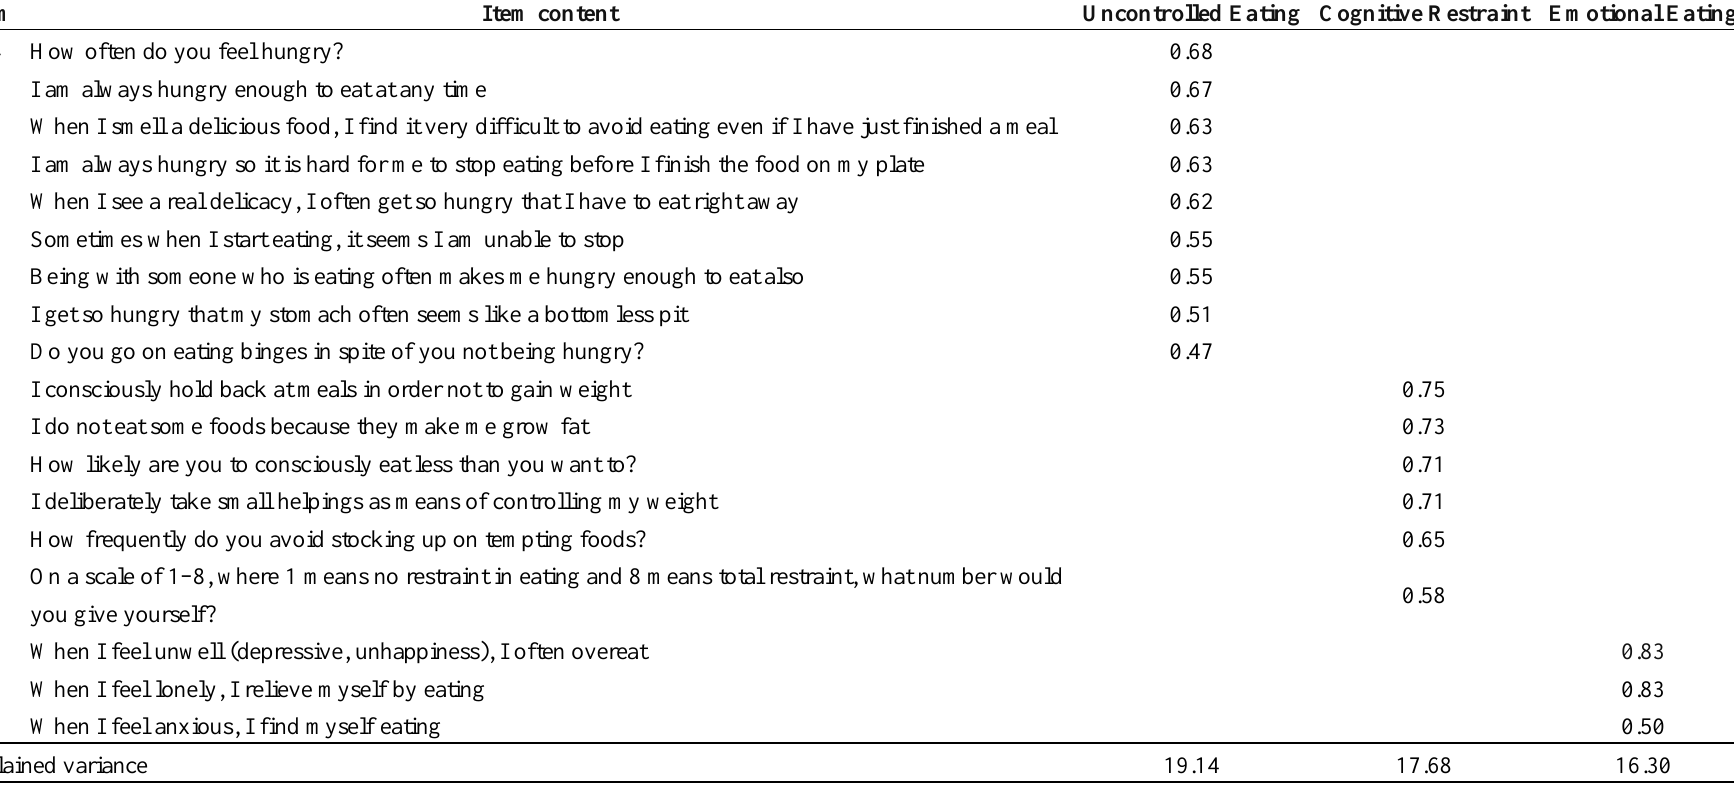
Table 3. Factor structure (principal components with varimax rotation) and explained variance of the